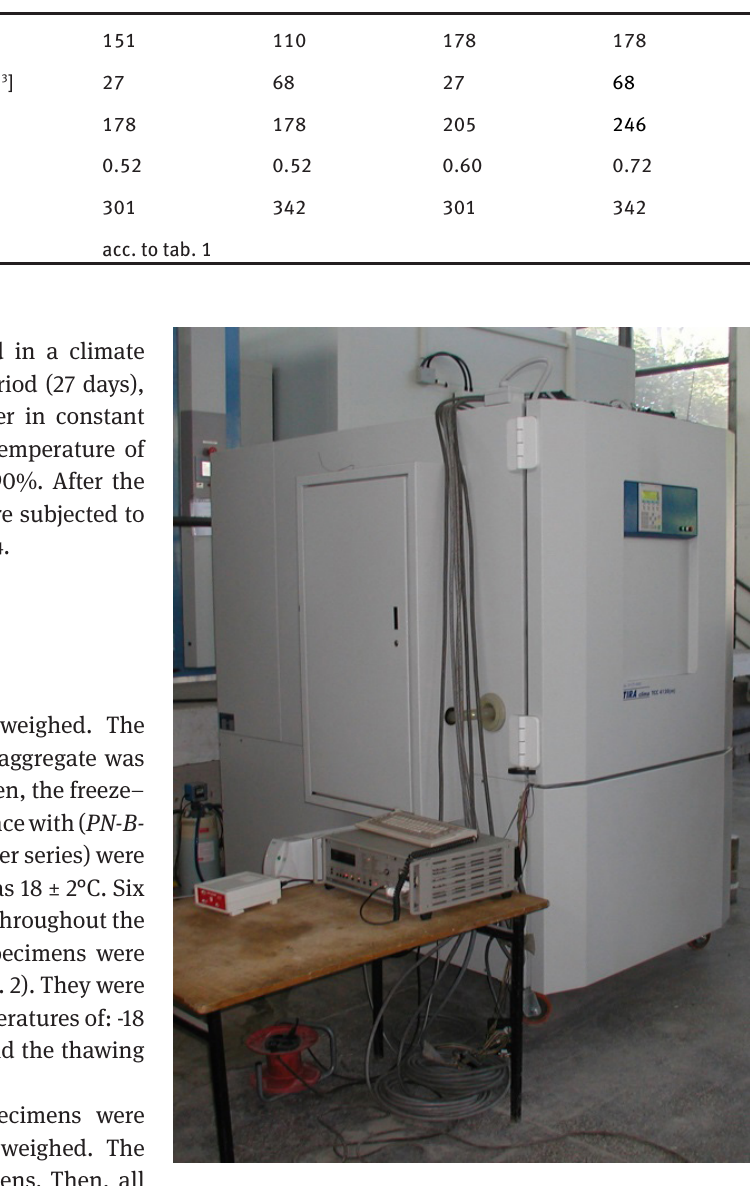
Figure 2: Automatic freezing